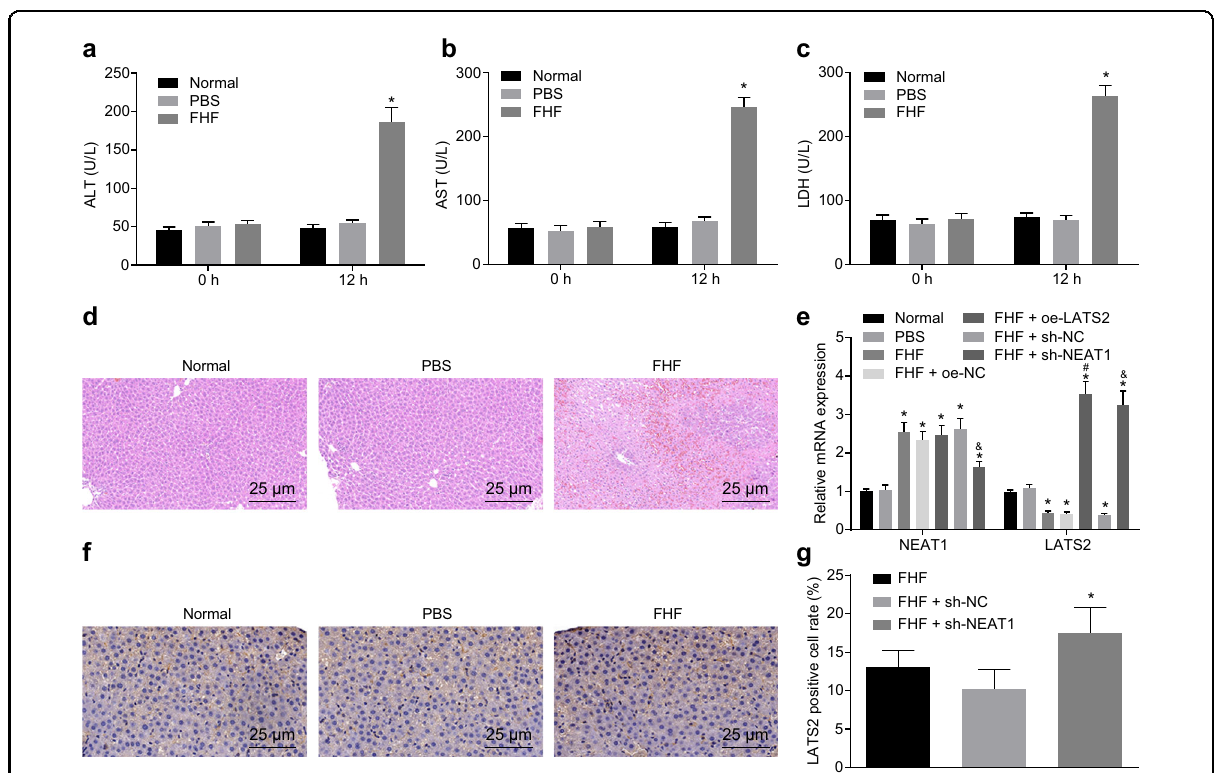
Fig. 3 Downregulation of lncRNA NEAT1 restores LATS2 expression in FHF rats. ALT, AST, and LDH expression patterns in the FHF rat model measured by ELISA ( a – c ). Liver pathology in FHF rats tested by HE staining ( d ). The lncRNA NEAT1 and LATS2 expression patterns in liver tissues of FHF rats evaluated by RT-qPCR ( e ). Immunohistochemical staining of LATS2 expression in liver tissues of FHF rats (×400) ( f ). Quanti fi cation of the results of immunohistochemical staining ( g ). * p < 0.05 vs. the normal group; # p < 0.05 vs. the FHF + oe-NC group; & p < 0.05 vs. the FHF + sh-NC group. Normal group, normal rats without injection; PBS group, normal rats injected with PBS; FHF group, FHF rats induced by D-GalN/LPS injection; FHF + oe-NC group, FHF rats treated with oe-NC; FHF + oe-LATS2 group, FHF rats treated with oe-LATS2; FHF + sh-NC group, FHF rats treated with sh-NC; FHF + sh-NEAT1 group, FHF rats treated with sh-NEAT1. Statistical data are described as mean ± standard deviation. One-way analysis of variance was used for comparisons among multiple groups, followed by Tukey ’ s post hoc test. n = 6. RT-qPCR reverse transcription quantitative polymerase